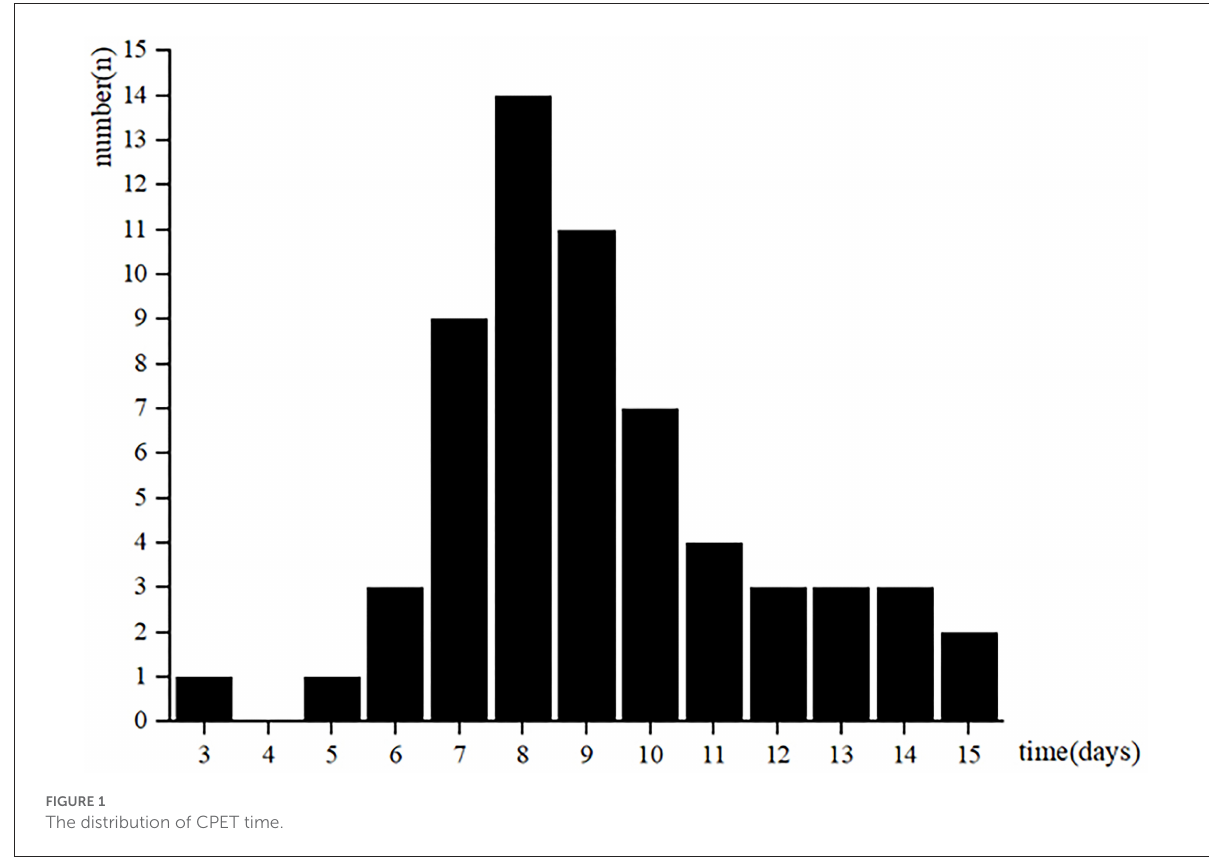
FIGURE1 The distribution of CPET time.